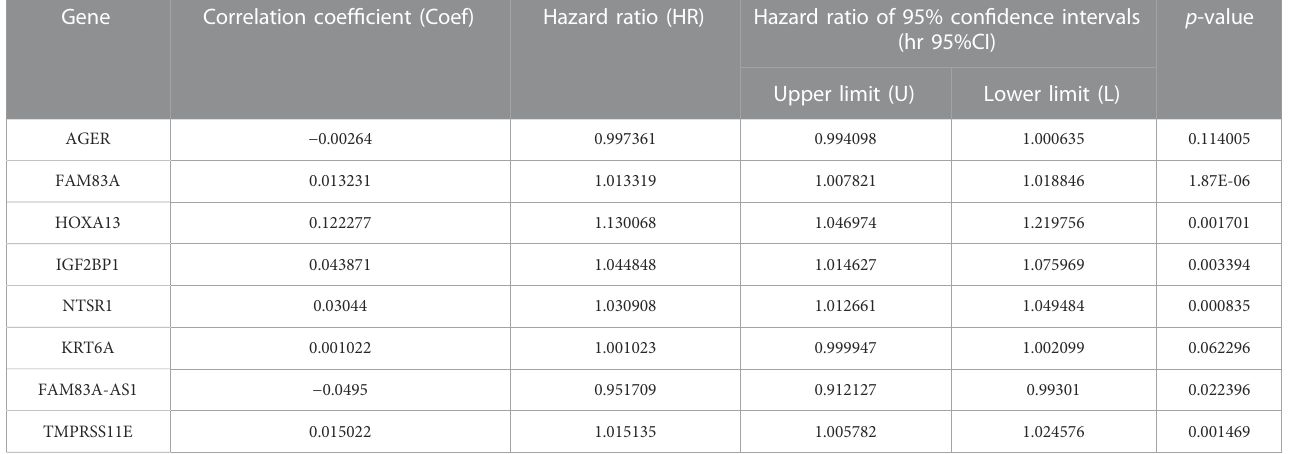
p -value (hr 95%CI) Upper limit (U) Lower limit (L)